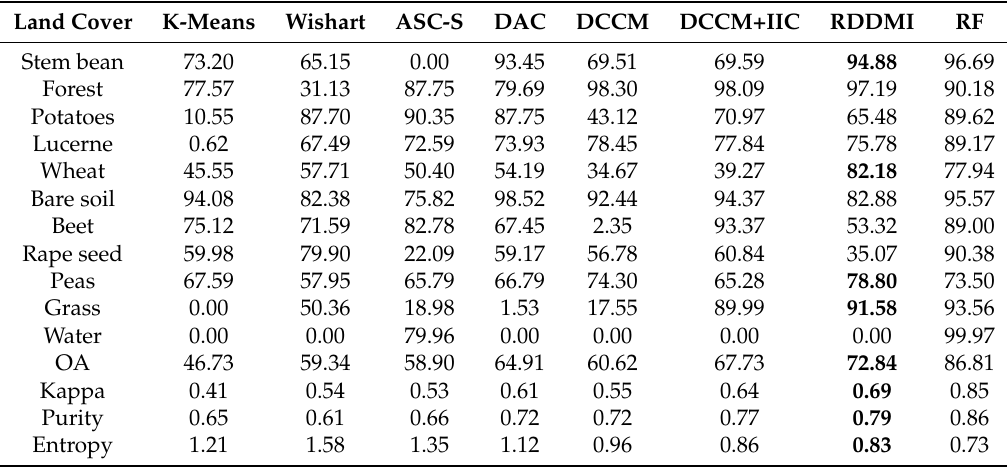
Table 4. Performance evaluation of AIRSAR Flevoland classification results. The numbers in bold denote the best unsupervised classification performance.